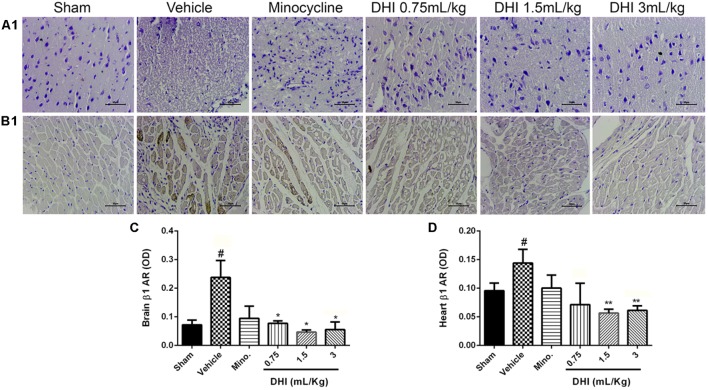
Similar and differential effects of DHI on β-AR subfamily member expression in CI/RI model. (A1,B1) Photomicrographs showing β1-AR expression in the brain and heart of Wistar rats, respectively. (C,D) Quantification of β1-AR in the brain and heart, respectively. Photomicrograph from IHC clearly showed brownish patches in the panels (A1,B1 from the vehicle; #p < 0.05 vs. vehicle) but almost invisible in both the sham and drug treatment groups (∗p < 0.05 and ∗∗p < 0.01 vs. vehicle). Minocycline treatment did not significant change β1-AR in the brain and heart (p > 0.05). All doses of DHI significantly ameliorated β1-AR accumulation in the brain (∗p < 0.05 vs. model; A1,C) where only DHI middle and high doses ameliorated the accumulation in the heart (∗∗p < 0.01 vs. model; B1,D). n = 3 in each group, image scale bar = 50 μm. Data are presented as mean ± SEM.